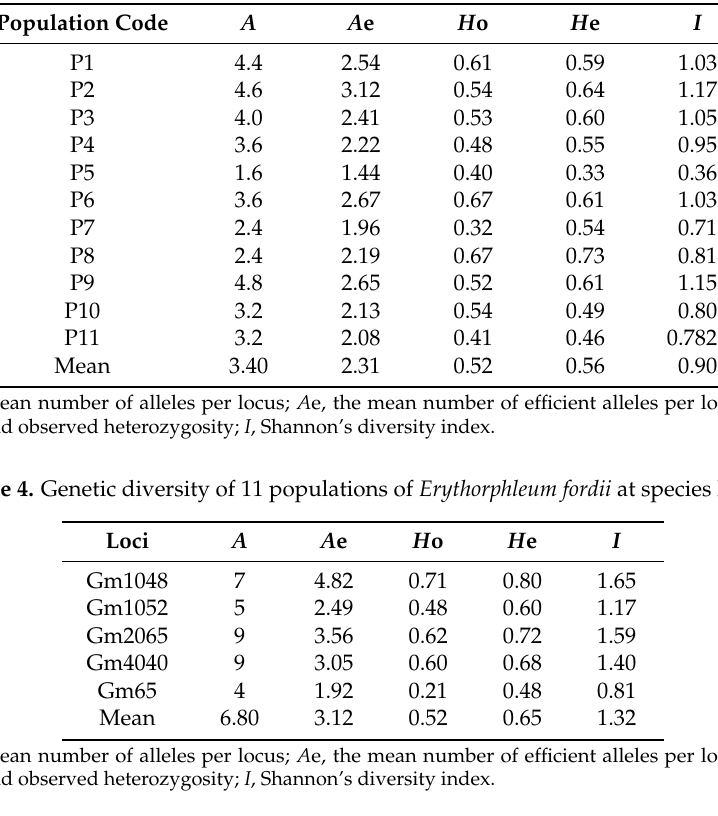
Table 3. Genetic diversity of 11 populations of Erythorphleum fordii .